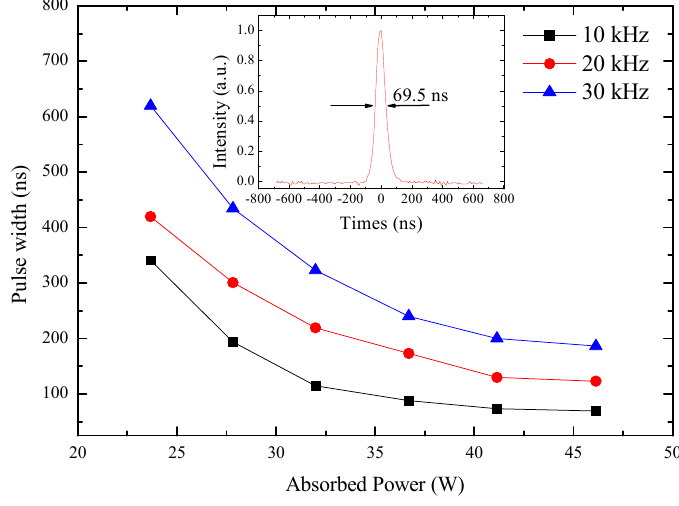
Figure 7. Pulse width versus absorbed powers for different PRFs. Inset: typical pulse trace.